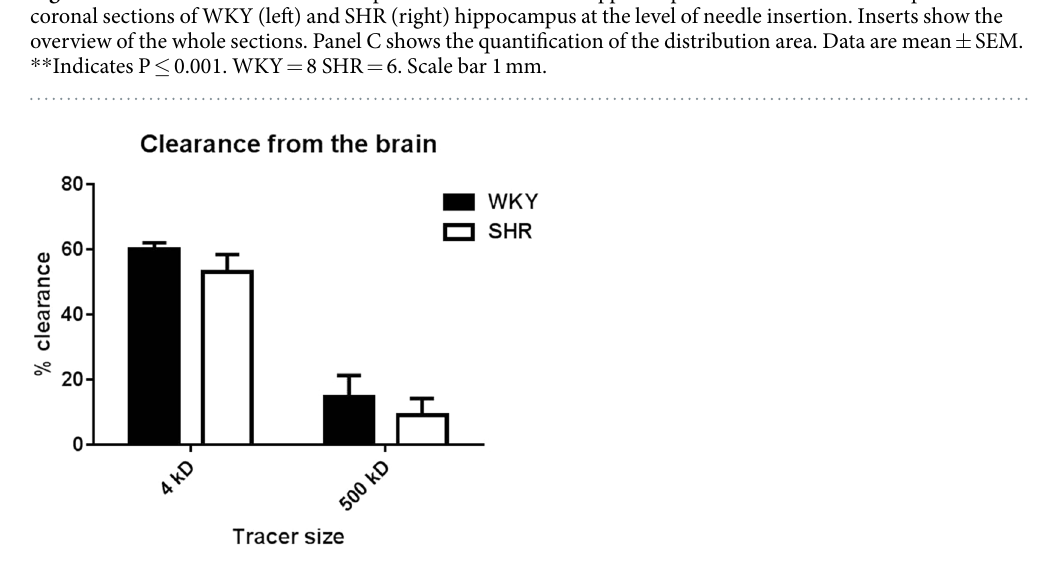
While the distribution area was different in size between infusion and passive release, the pattern was similar. In both cases, tracers spread and accumulated at the stratum lacunosum moleculare (SLM), around arteries, into the corpus callosum, and at the edges of the hippocampus including the border with the third ventricle. This was the case for both WKY and SHR, albeit this became only apparent after infusion in the WKY, since there was limited tracer spreading after passive release in this group. Immunostaining showed that these areas are rich in astrocytes, and strongly express aquaporin 4. Thus, it appears that ISF, containing tracers, travels from the paren- chyma towards these border zones where ISF mixes with CSF. While in general the ISF-CSF border is considered less tight than the BBB, barrier properties are apparently still significant and lead to accumulation of the tracers.